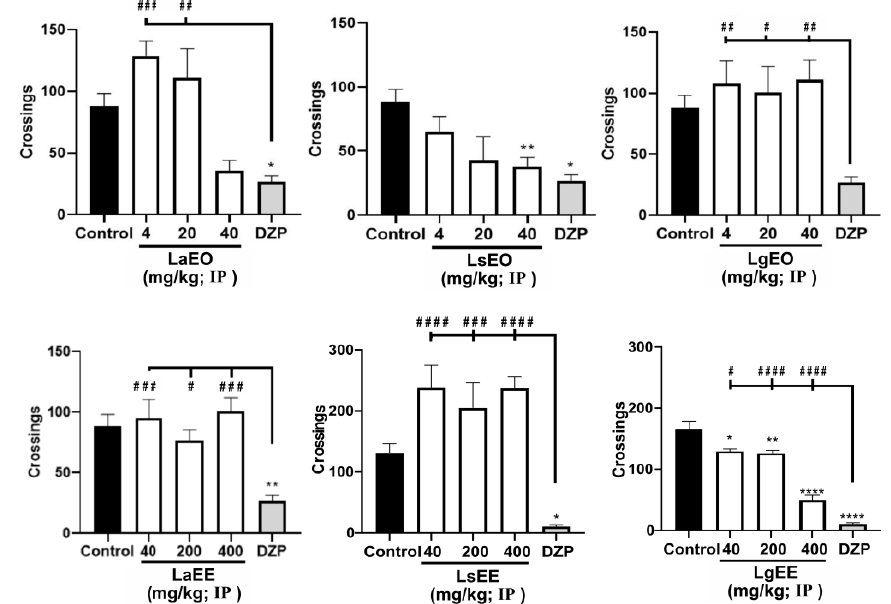
Figure 4. Effect of essential oils and ethanolic extracts of L. alba , L. sidoides , and L. gracilis on the locomotion of adult zebrafish animals in the open field test (0 – 5 min). The values represent the